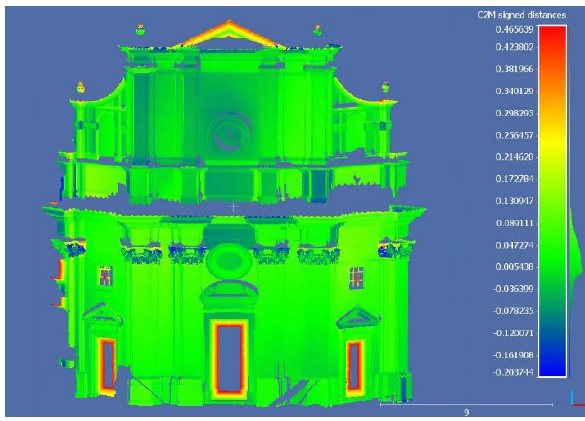
Figure 9. Result of the comparison between point cloud and mathematical